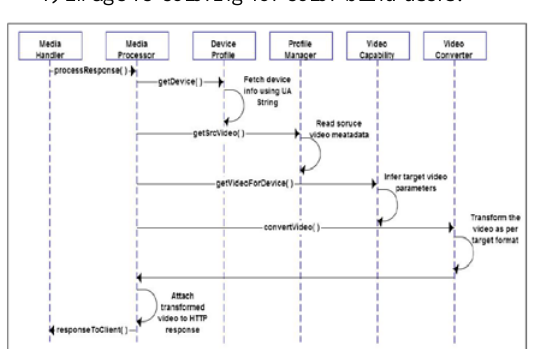
Fig. 3. Process Flow of Video